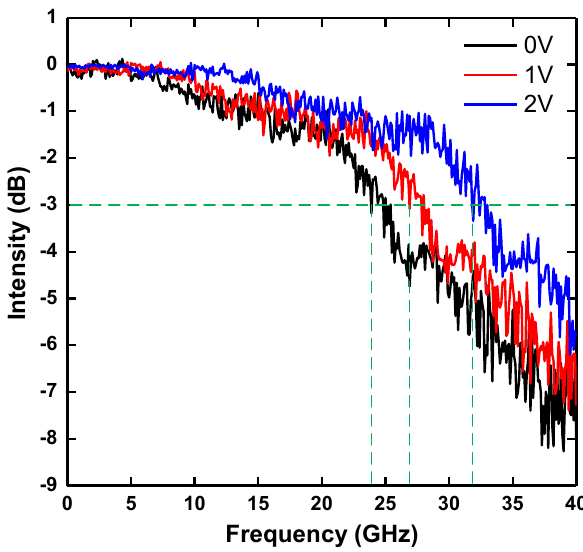
Figure 10: Normalized high frequency response of the fabricated